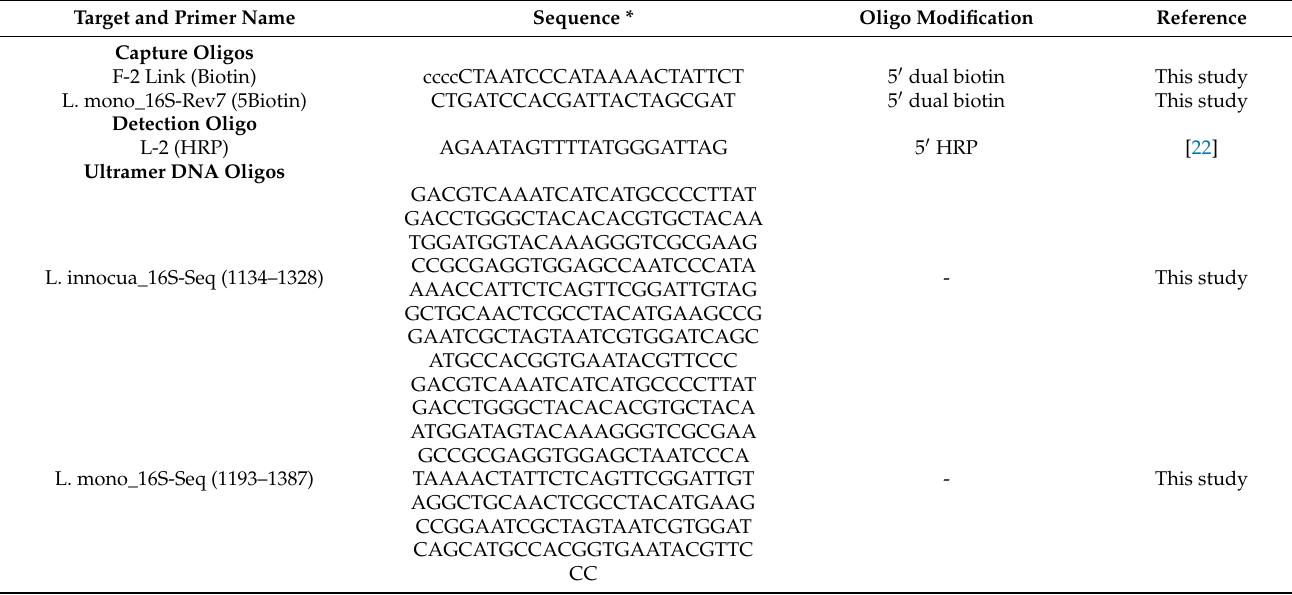
Table 2. Oligos used during the development of the enzyme-amplified electrochemical